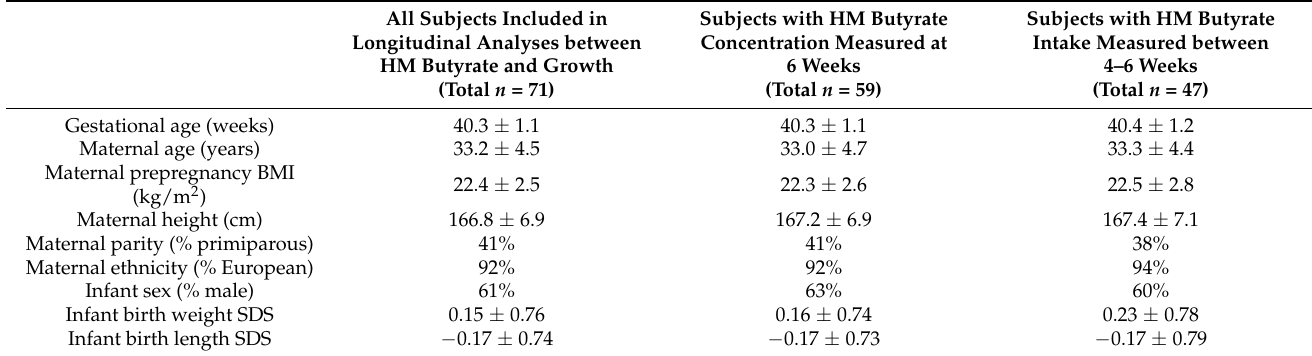
Table 1. Baseline characteristics of mother–infant dyads based on sample availability.